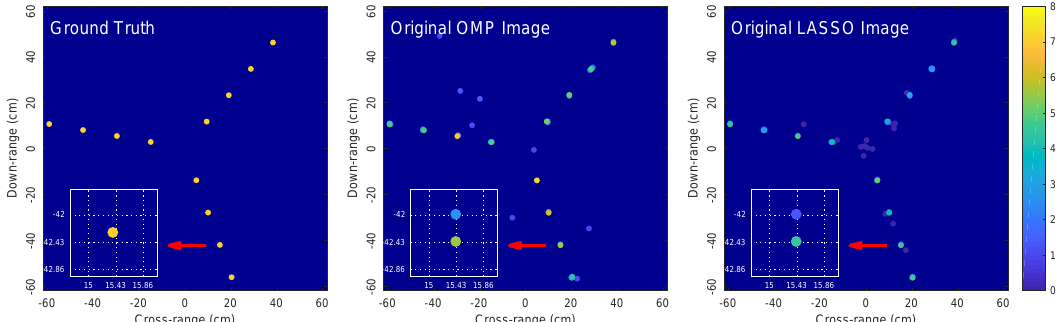
Figure 3. Reconstructed images obtained by OMP and LASSO for the same simulation setup as in Figure 2 but with the grid step reduced to λ /7, i.e., x λ /7 : 25 λ } . The zoomed-in images show the locations of the solution atoms relative to a true scatterer (ground truth); here, dictionary grid points are located at intersections of dotted